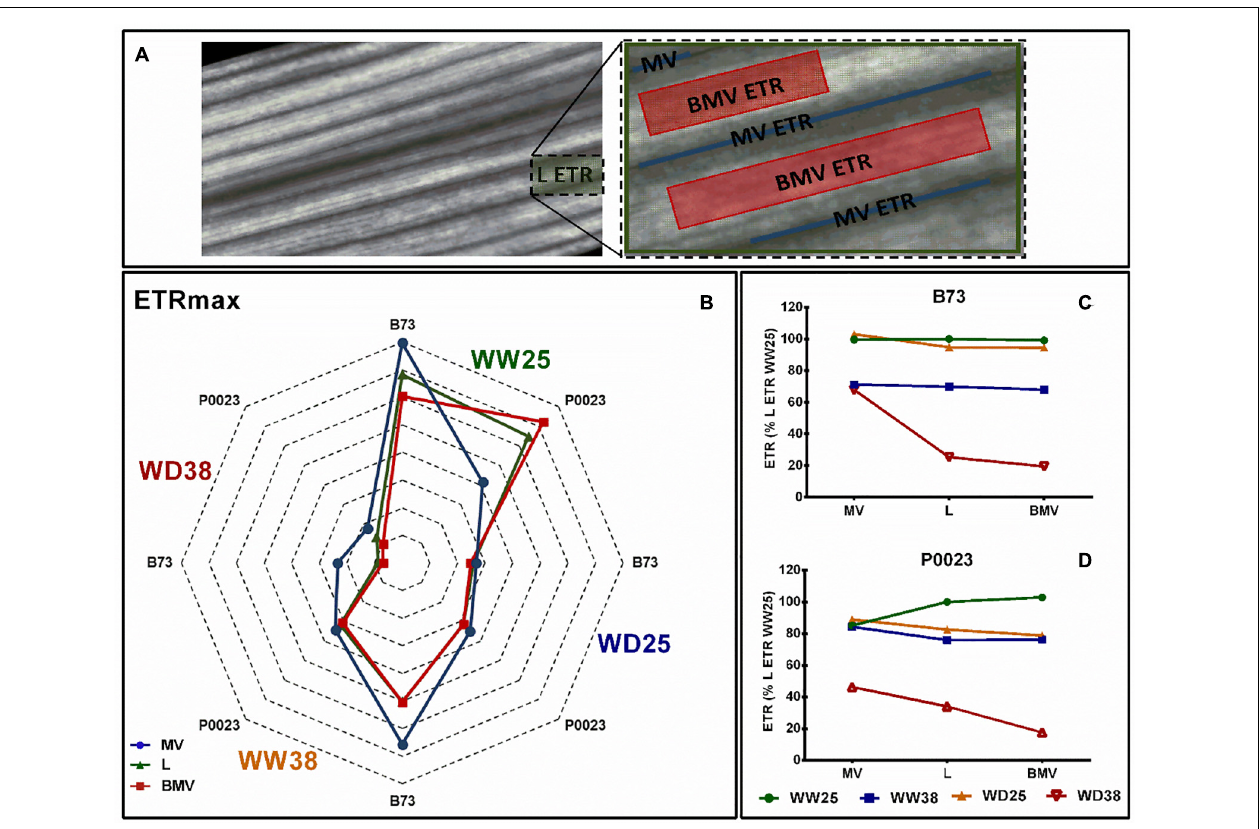
FIGURE 6 | The leaf photosynthetic heterogeny of two maize genotypes (B73, P0023) grown under WW and WD conditions and acclimatized to 25 or 38 ◦ C. (A) Leaf (L), MVs, and BMVs AOI from a representative chlorophyll a fluorescence image. (B) Maximal ETR and (C,D) growth irradiance ETR extracted from AOIs in fully expanded leaves from 4-week-old maize. ETRmax estimated from a three-parameter photosynthesis-irradiance model (Platt et al., 1982), n = 5 biological replicates, (C,D) data normalized to L ETR under WW25.